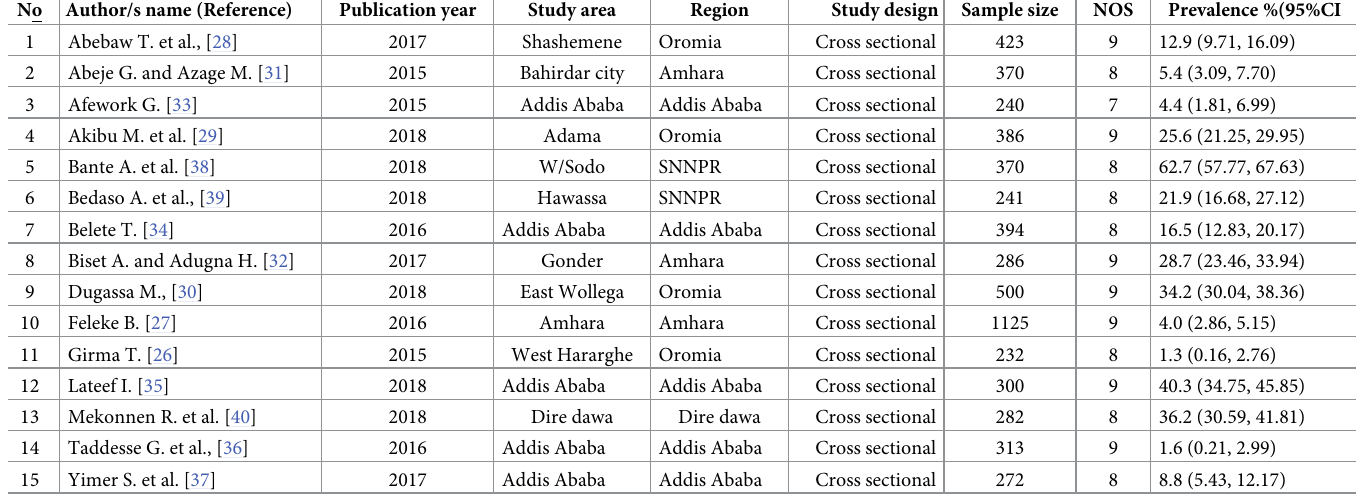
Table 1. Characteristics of the included studies in the systematic review and meta-analysis for the prevalence of full-dose hepatitis B vaccination coverage among health care workers in Ethiopia,